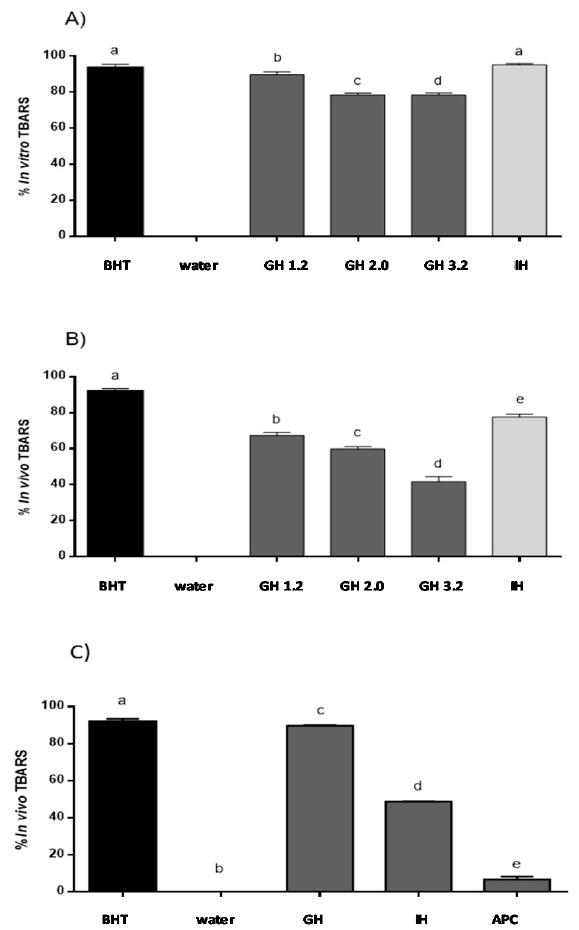
Figure 3. Lipid peroxidation inhibitory capacity of gastrointestinal hydrolysates of APC. ( a ) In vitro TBARS inhibitory capacity ( b ) TBARS inhibitory capacity evaluated in the in vivo zebrafish larvae model with hydrogen peroxide (H 2 O 2 ). ( c ) TBARS inhibitory capacity evaluated in the in vivo zebrafish larvae model with ethanol. BHT: positive control, distilled water: negative control, GH (gastric hydrolysate at pH 1.2, pH 2.0 and pH 3.2, IH (gastrointestinal hydrolysate with pepsin pH 3.2 and pancreatin pH 7.0). Data were analyzed using one-way ANOVA and followed by Tukey’s test. Different letters over bars represent statistical differences between groups samples with p < 0.05 (n = 3).